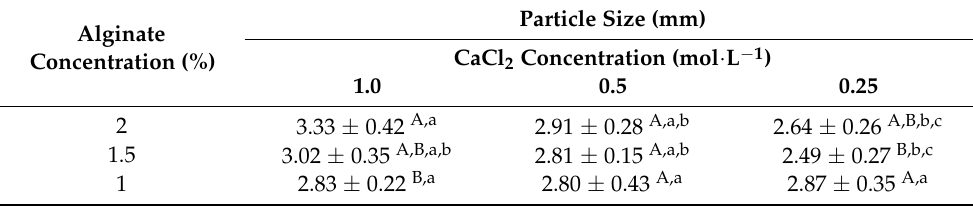
Table 1. Size of particles obtained using different concentrations of sodium alginate and calcium chloride (CaCl 2